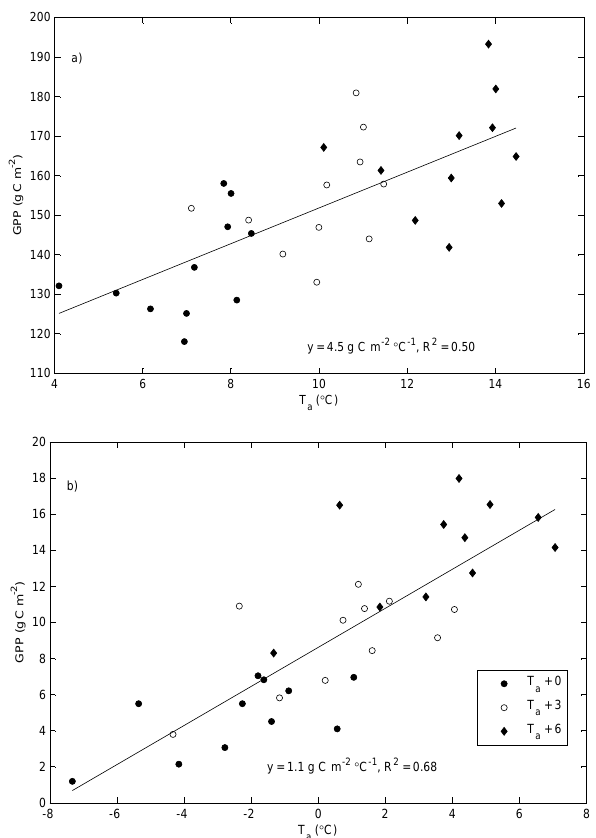
Fig. 5. Modeled cumulative GPP as a function of mean air tem- perature ( T a ) in early (September–October) (a) and late autumn (November–December) (b) periods. The different symbols show the three temperature scenarios (present, +3 ◦ C and +6 ◦ C). The lin- ear least-squares fit show the average temperature sensitivity over all data points in each